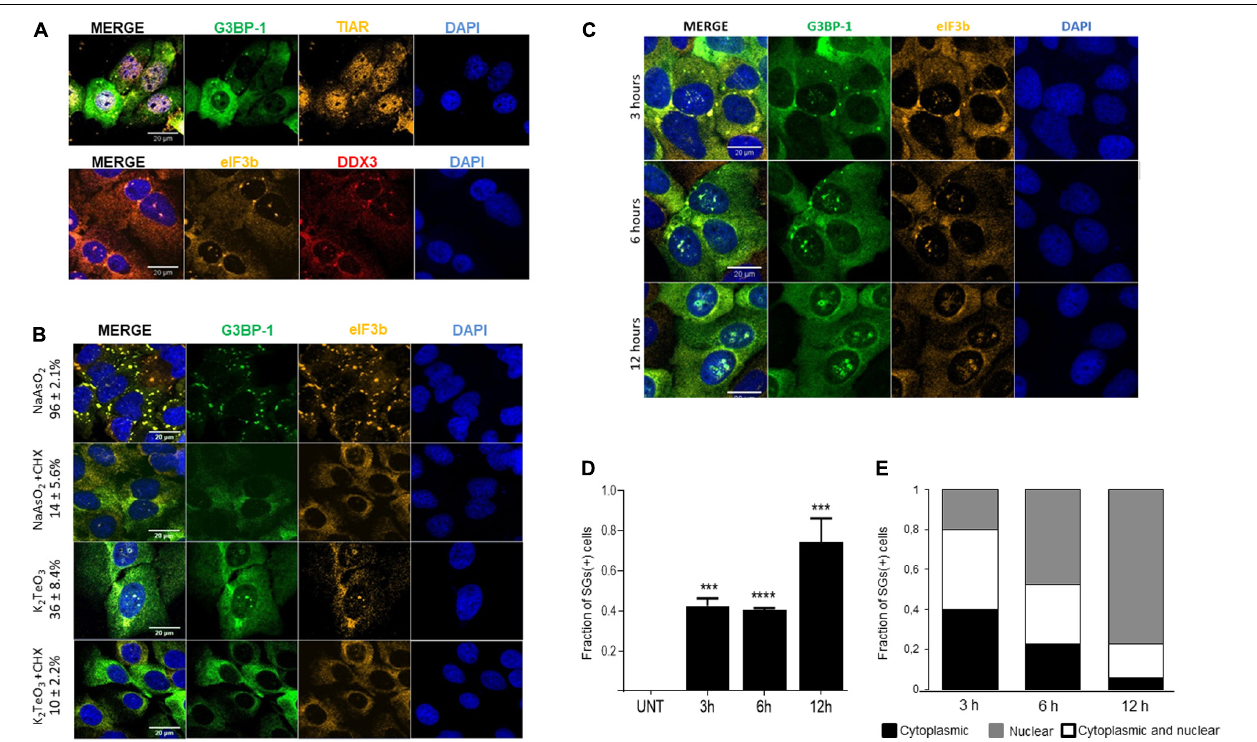
FIGURE 2 | Tellurite treatment induces stress granules (SGs) assembly. (A) U2OS GFP-G3BP-1 cells were treated with 0.6 mM tellurite (K 2 TeO 3 ) for 3 h and assessed for SG markers by indirect immunofluorescence. Tellurite-induced SGs contain GFP-G3BP-1 (green) and TIAR (yellow) as shown in the upper panel and DDX3 (red) and eIF3b (yellow) in the bottom panel. Nuclei were stained with DAPI (blue). Images are representative from 2 different experiments. (B) Tellurite-induced SGs are disassembled by cycloheximide (CHX). U2OS GFP-G3BP-1 cells were exposed to 0.3 mM arsenite (NaAsO 2 ) or 0.6 mM tellurite (K 2 TeO 3 ) for 1 and 3 h, respectively. Then, cells were co-incubated for an additional 1 h with CHX and immunostained for eIF3b (red). Nuclei were stained with DAPI (blue). Mean ± SD of SGs (+) cells in each condition is shown. Images are representative from 2 independent experiments. (C) Tellurite promotes cytoplasmic and nuclear SGs-like formation. U2OS GFP-G3BP-1 were treated with 0.6 mM tellurite (K 2 TeO 3 ) for 3, 6, or 12 h, fixed and immunostained for eIF3b (yellow). Nuclei were stained with DAPI (blue). Images are representative from 2 different experiments. (D) Quantification of the fraction of SG-positive cells in the presence of 0.6 mM of tellurite (K 2 TeO 3 ). Data represented as means ± SD ( ∗∗∗ p = 0.0004, ∗∗∗∗ p < 0.0001 relative to untreated cells by unpaired t -test). (E) Cells were treated with 0.6 mM tellurite (K 2 TeO 3 ) for 3, 6, or 12 h and quantification of subcellular location of tellurite-induced SGs was performed and plotted as fraction of cells with only cytoplasmic SGs (black), both cytoplasmic and nuclear SGs-like (white) and only nuclear SGs-like (gray). Data represent 45 cells analyzed per